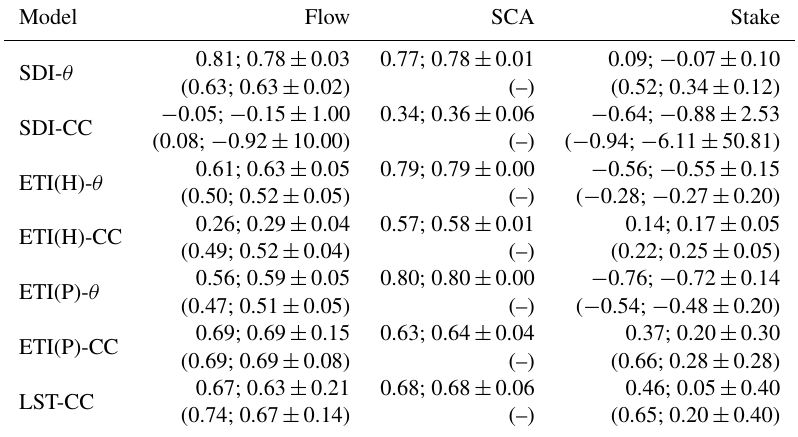
Table B5. Best model evaluation scores during validation for Gulkana; parameter sets are calibrated for Wolverine. The top row for each model is 1 minus the PBE score for the “SCA” columns and the KGE score for the “flow” and “stake” columns; the bottom row is the NSE score.